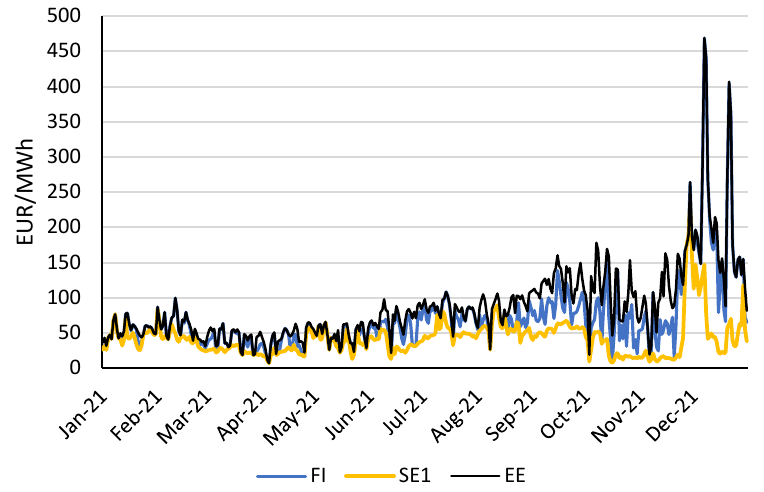
Figure 4. Daily spot prices in Finland, Estonia, and SE1 in 2021. Finnish Price Peak on 7 December 2021